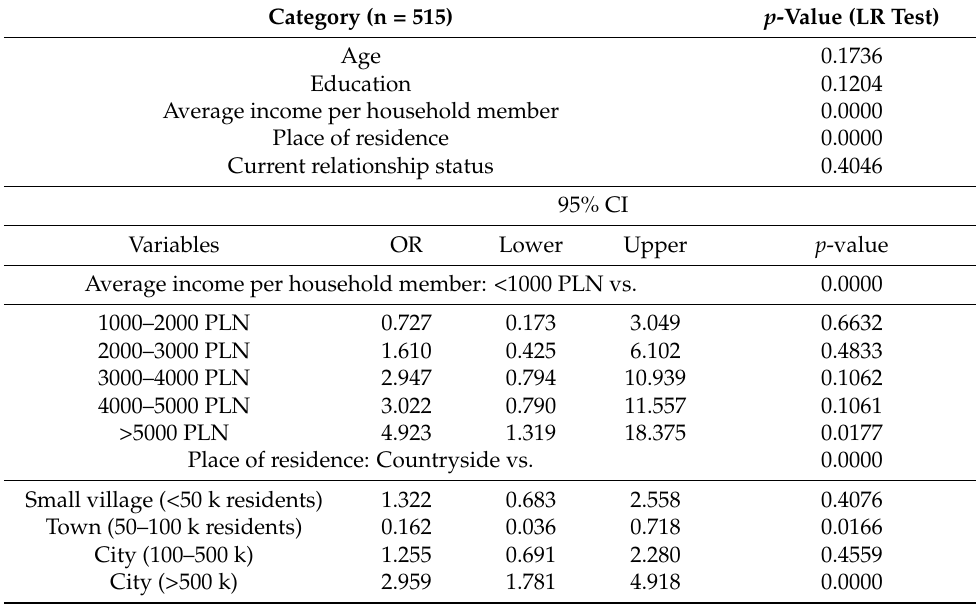
Table 5. Univariate regression analysis regarding influenza vaccination status during current pregnancy.